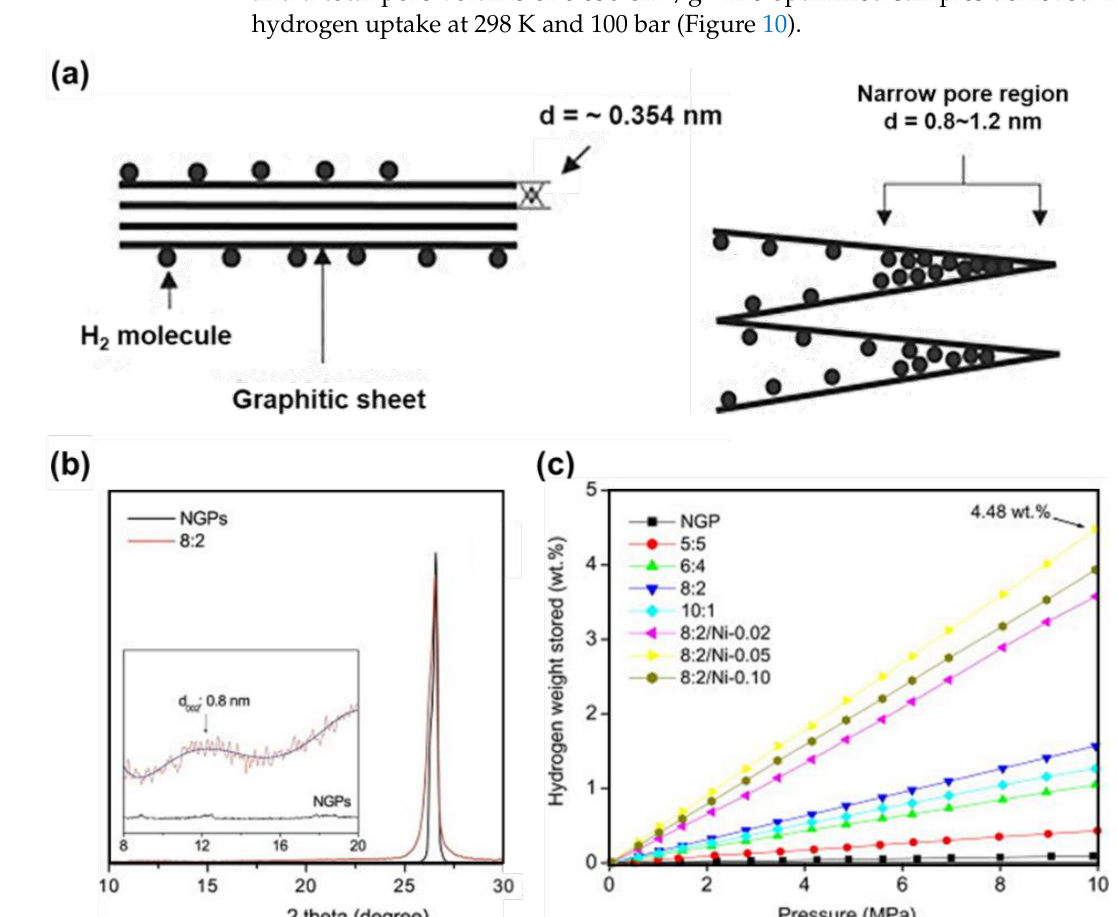
Figure 10. ( a ) Illustration of hydrogen adsorption sites of graphitic surfaces: natural graphite (NPG, left) and porous graphite (PG, right). ( b ) XRD of NPG and nickel/PG hybrids. ( c ) Hydrogen adsorption curves at 298 K and 100 bar. Reproduced from ref. [131]; copyright (2011) with permission from Elsevier.